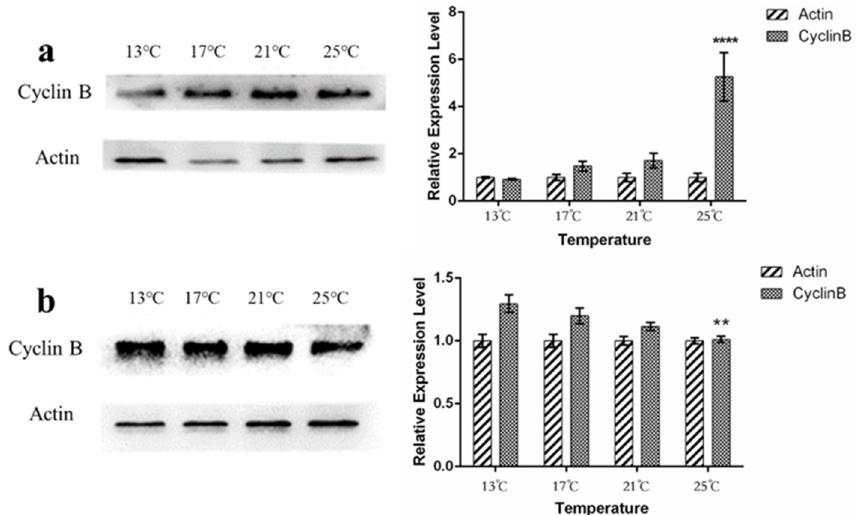
Figure 8. The protein level of Cyclin B in N. yezoensis incubated at different temperatures: ( a ) the expression of Cyclin B increased with the increase in temperature at 12 h; ( b ) the expression of Cyclin B decreased with the increase in temperature at 72 h. Data represent mean ± standard errors ( n = 3). ** p < 0.01, **** p < 0.0001, vs. 13 °C.